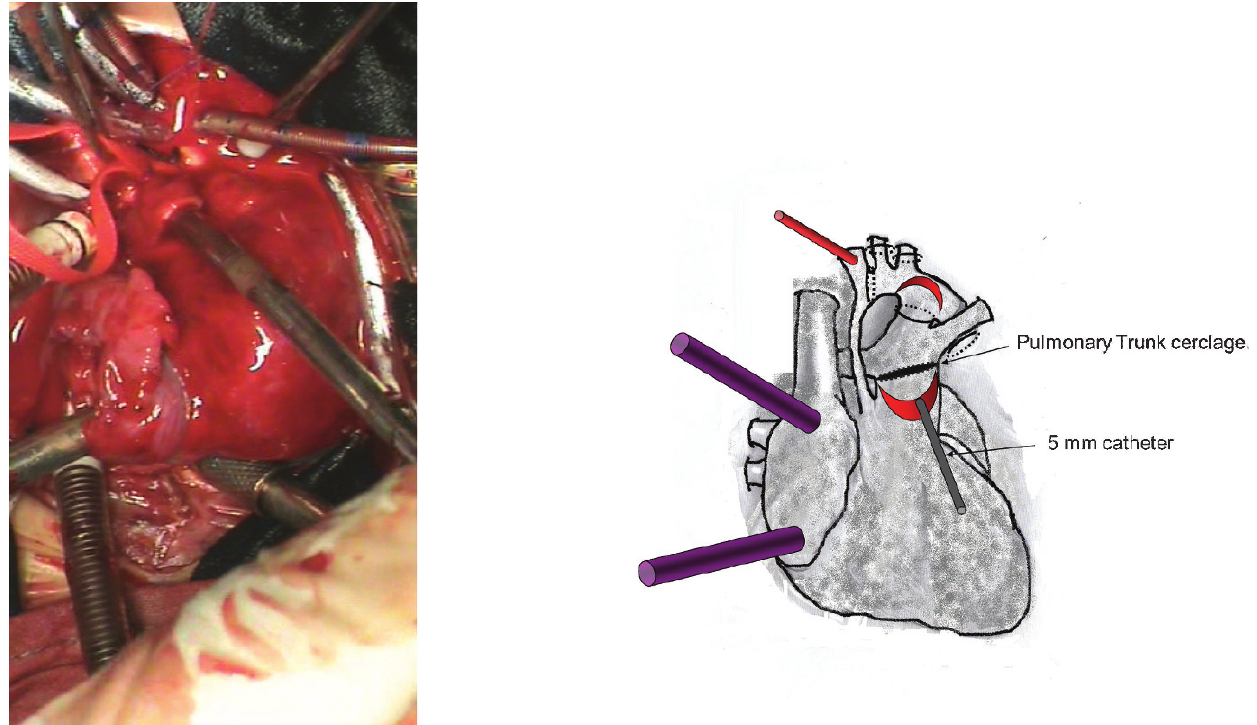
Figure 2 - A photograph and diagrammatic schema of the introduction of a 5 mm catheter through the opening of the pulmonary trunk, toward the pulmonary arteries. We placed the pulmonary trunk cerclage around this catheter using cardiac tape sutured with 5- 0 Prolene.